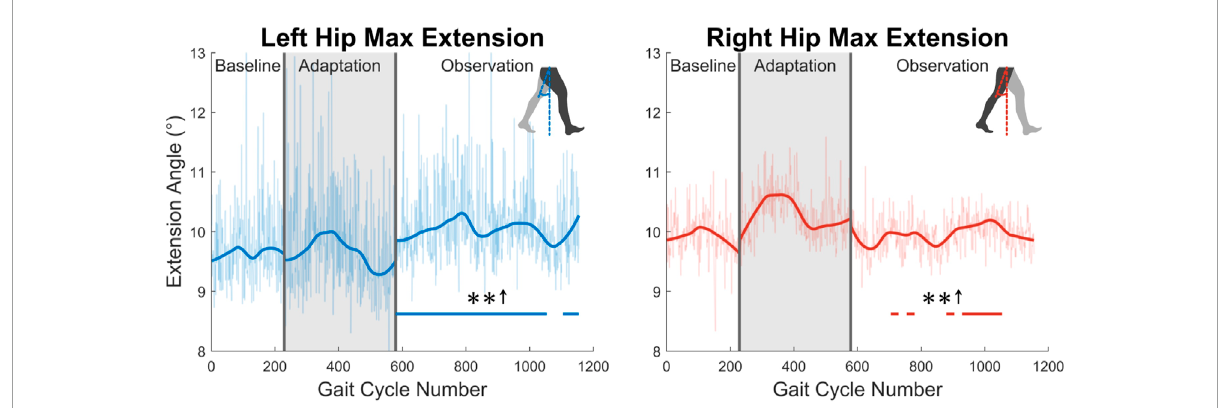
FIGURE 7 Maximum hip extension throughout the gait cycle for left and right legs. Note that values are positive because the extension angle was used instead of the flexion/extension angle for this figure. Significance is shown in the observation phase as compared to the baseline phase by the significance line. All significance testing was performed on “unsmoothed” data (seen in the lighter line). The darker line is the data smoothed by 2nd-degree polynomial local regression and was added only to allow the reader to more clearly see trends in the